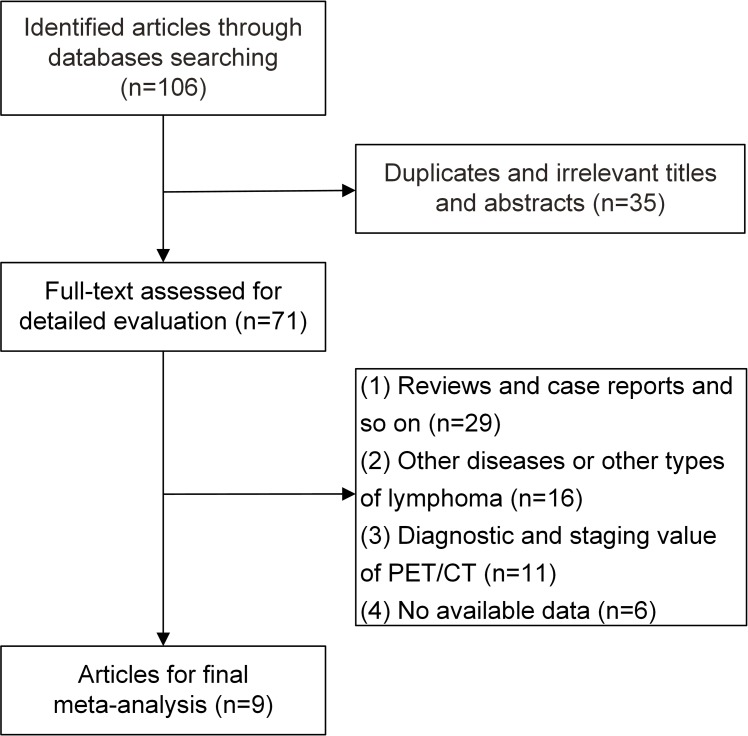
Flow diagram of study selection.